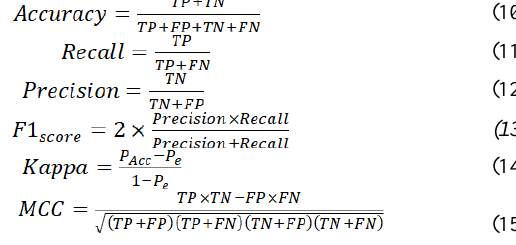
Table 1. Results of the reference models for the three feature